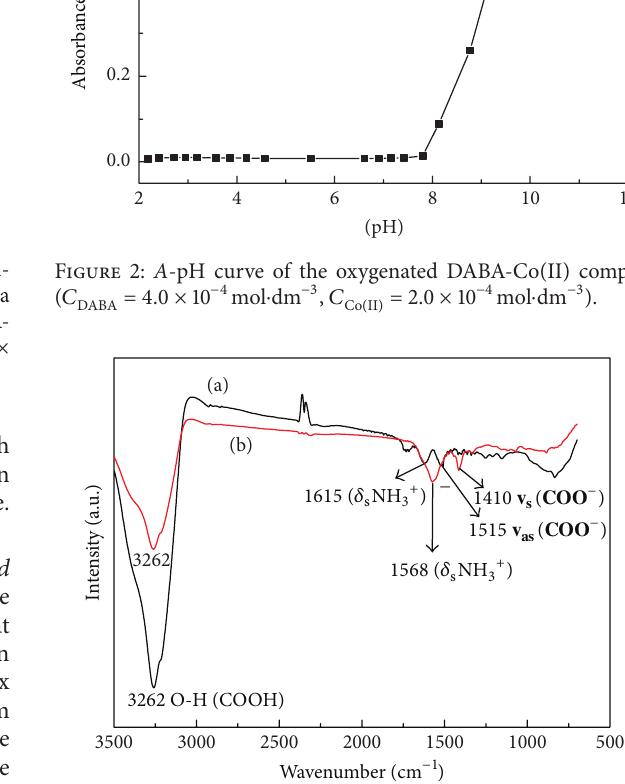
Figure 3: IR spectra of DABA (curve (a)) and DABA-Co(II) (curve (b)) ( 𝐶 = 1.0 mol ⋅ dm −3